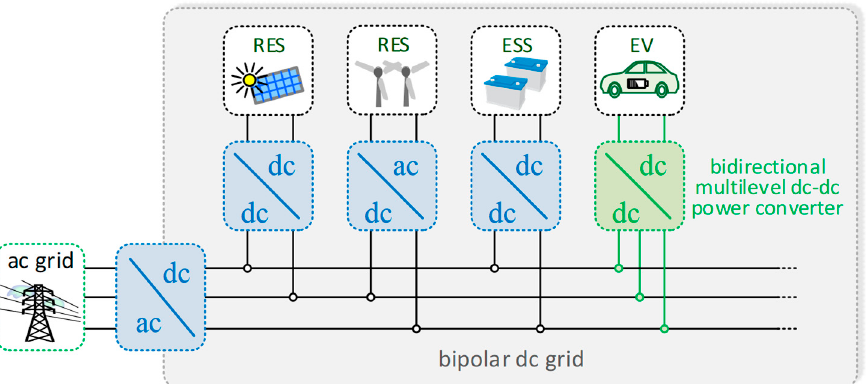
Figure 1. Conventional configuration of a bipolar dc grid, emphasizing the contextualization of the bidirectional multilevel dc–dc power converter for EV battery charging.